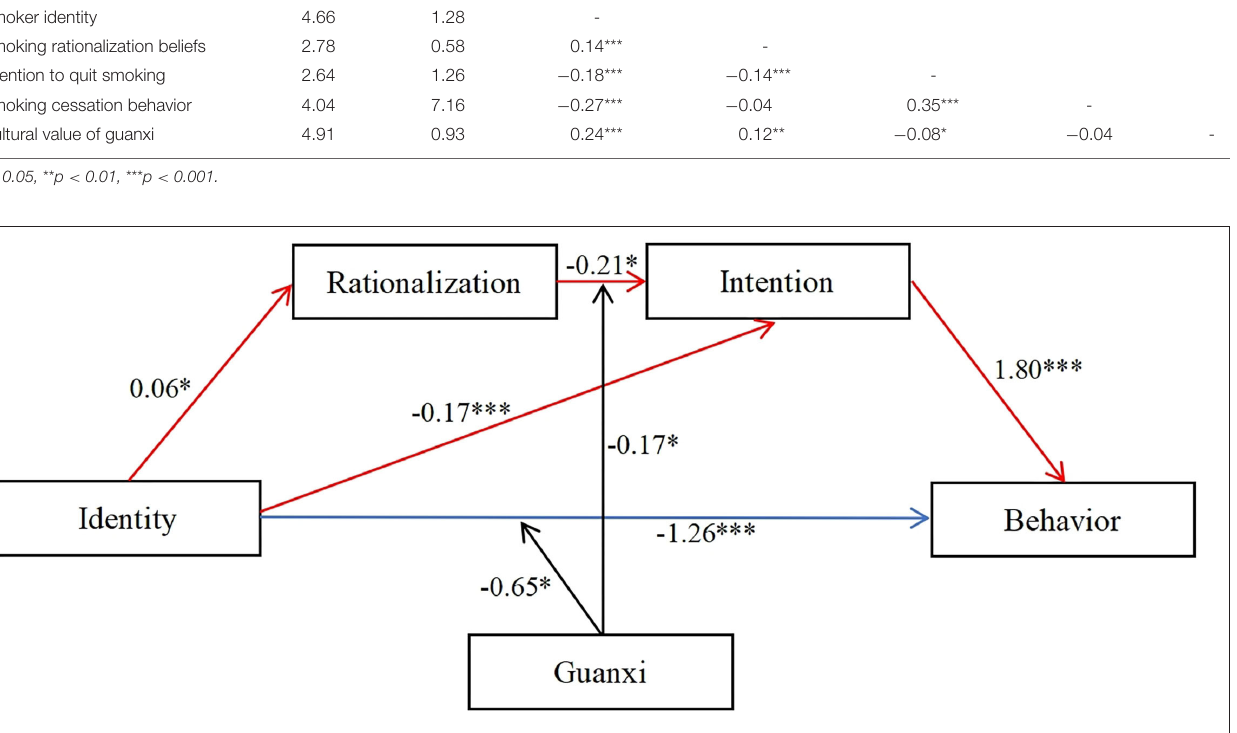
by Model 6 and 92 of PROCESS macro (42) in SPSS. The standard error and 95% confidence interval of the parameter estimation were obtained by bootstrapping method (repeated sampling 5,000 times). In addition, simple slope analyses were